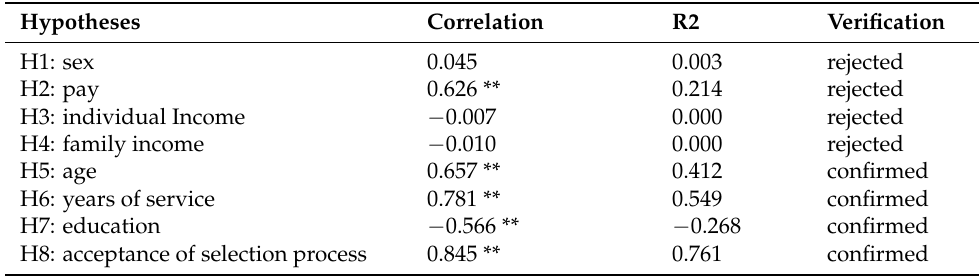
Table 6. Hypotheses